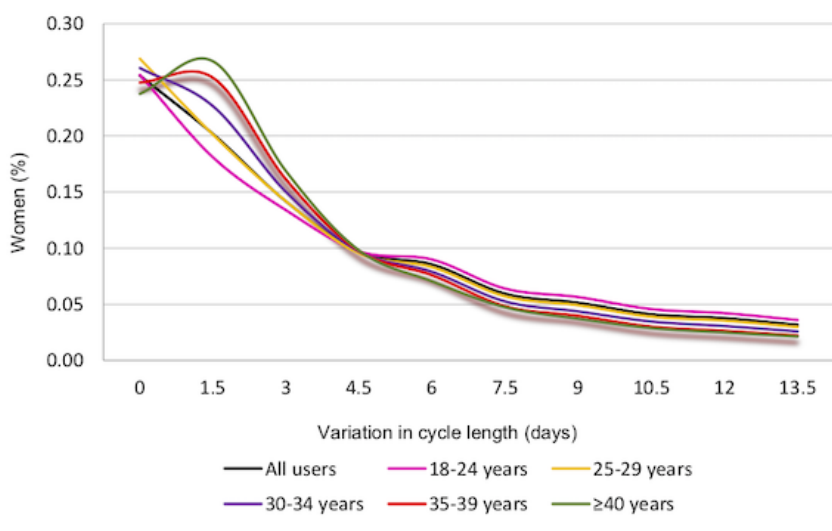
Figure 3. Variation in cycle length across age